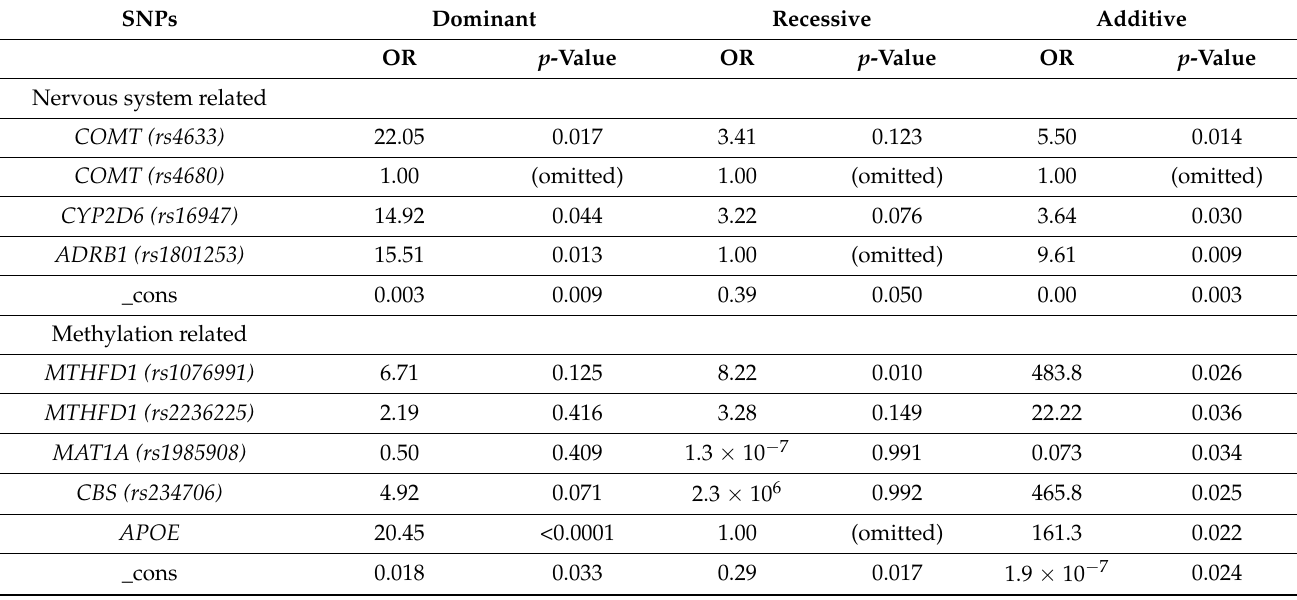
Table 4. Significant predictors of AD status assessed in various inheritance models.